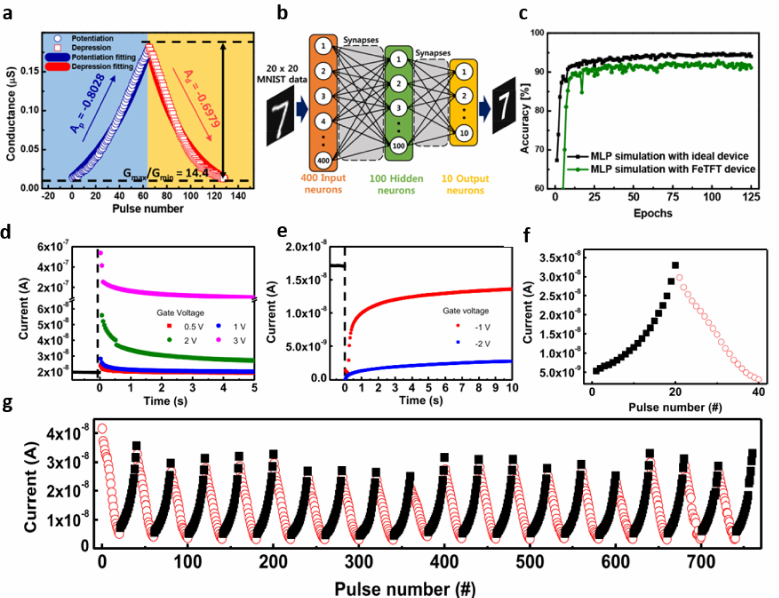
Figure 10. ( a ) Potentiation and depression characteristics of FeTFT with incremental pulse scheme; ( b ) Schematic illustration of two-layer multilayer perceptron neural network; ( c ) Simulated pattern recognition accuracy of the two-layer multilayer perceptron neural network based on the ferroelectric FeTFT compared to an ideal neuromorphic device (adapted from [126] with permission from the American Chemical Society); ( d ) Positive gate voltage spikes (0.5 V, 1 V, 2 V, 3V); ( e ) Negative gate voltage spikes ( − 1 V, − 2 V); ( f ) Potentiation and depression characteristics with 20 consecutive positive voltage spikes and negative voltage spikes; ( g ) Potentiation and depression characteristics under repetitive cycling for 760 pulses (adapted from [128] with permission from the Elsevier